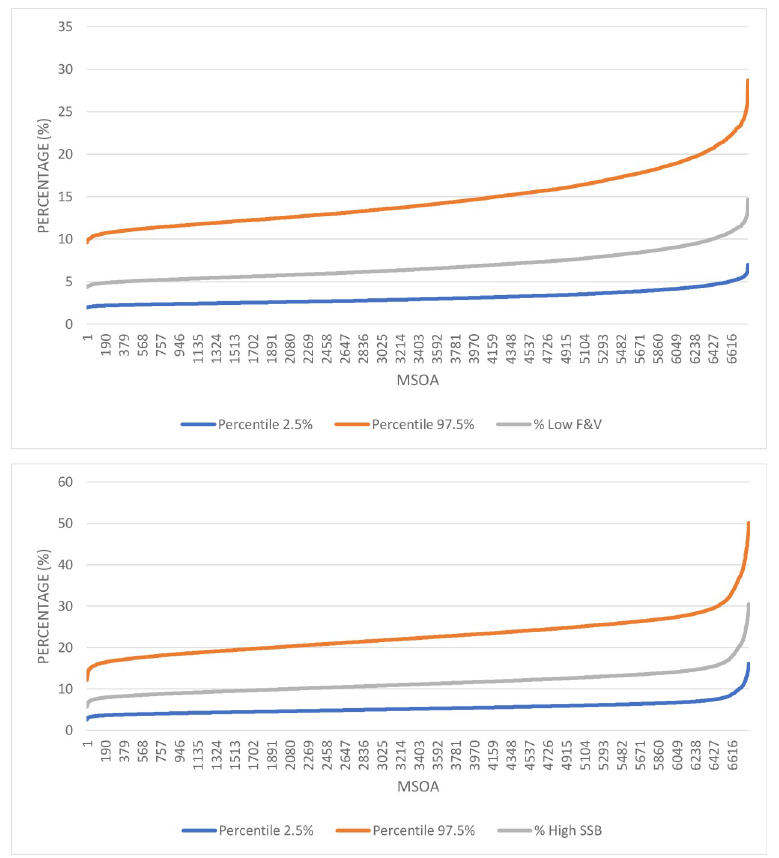
Fig 5. Credible intervals. Credible intervals around a sample of the estimates of SSB and overall fruit and vegetable consumption.